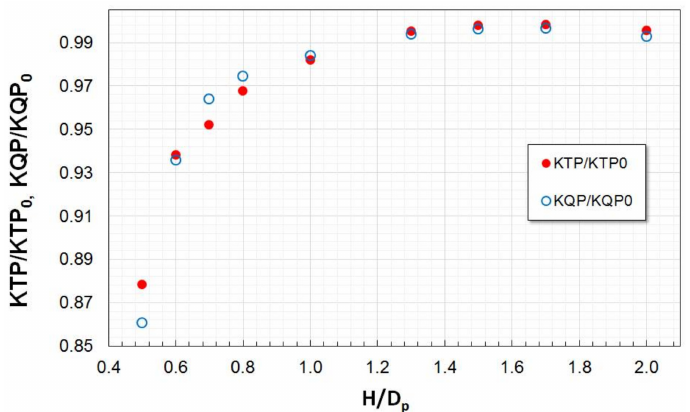
Figure 19. Variations in propeller thrust, KTP, and propeller torque, KQP, with propulsor submergence,